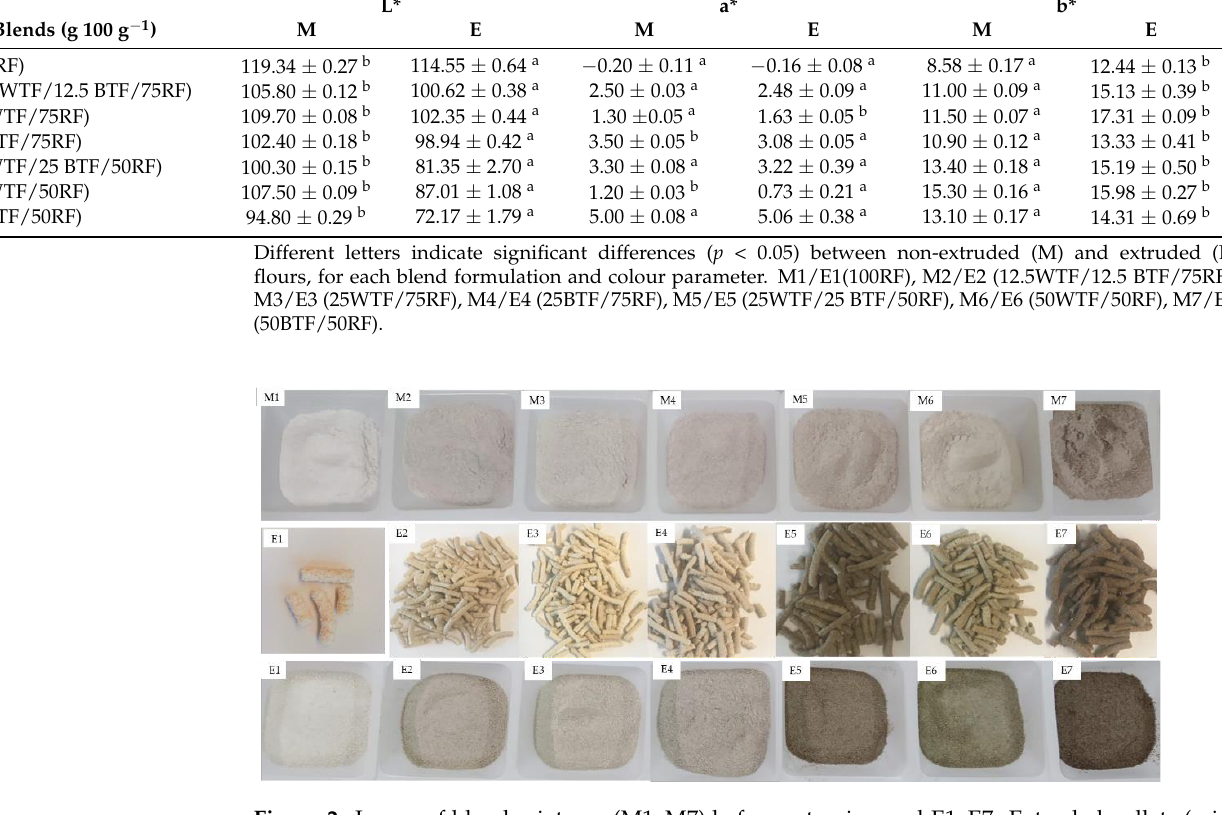
Table 3. Colorimetric analysis (CIE L* a* b*) of different blend flours (1–7). L*